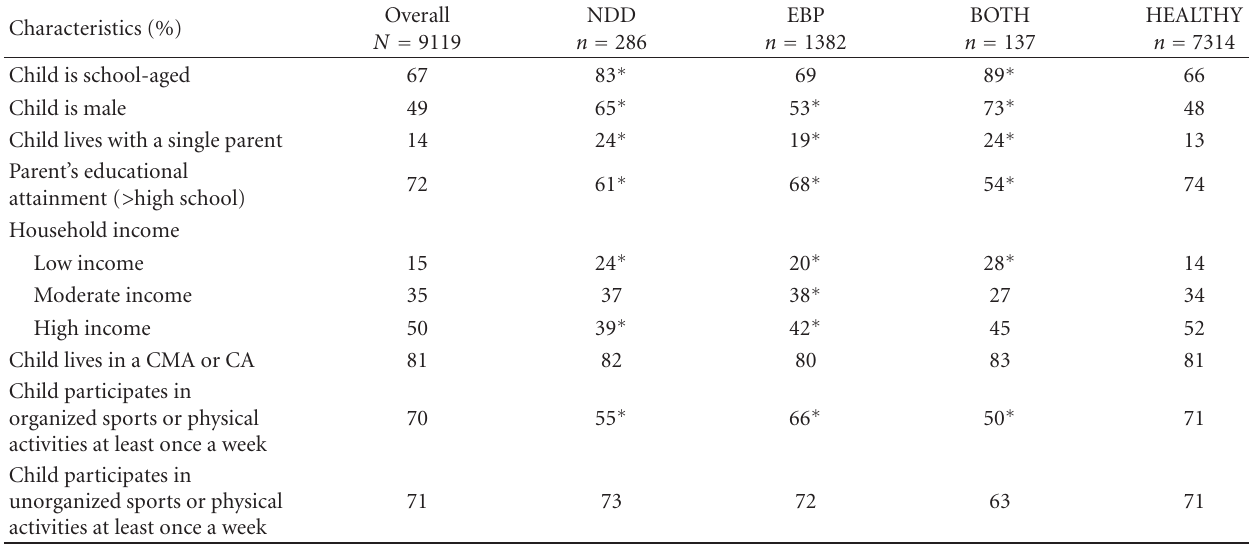
Table 1: Descriptive statistics of all study variables.